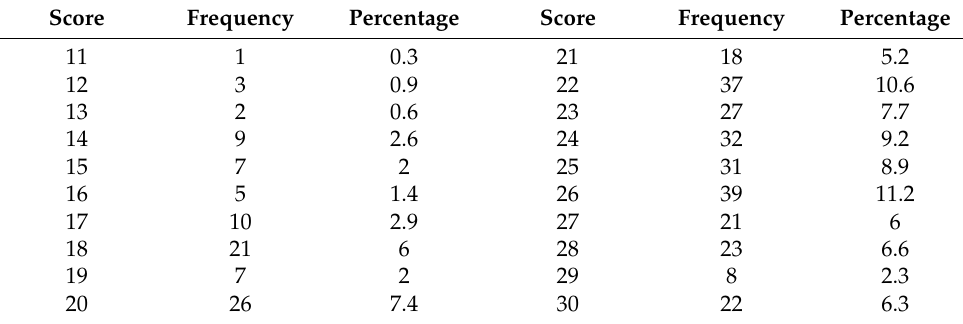
Table 5. Tax knowledge scores of the respondents.